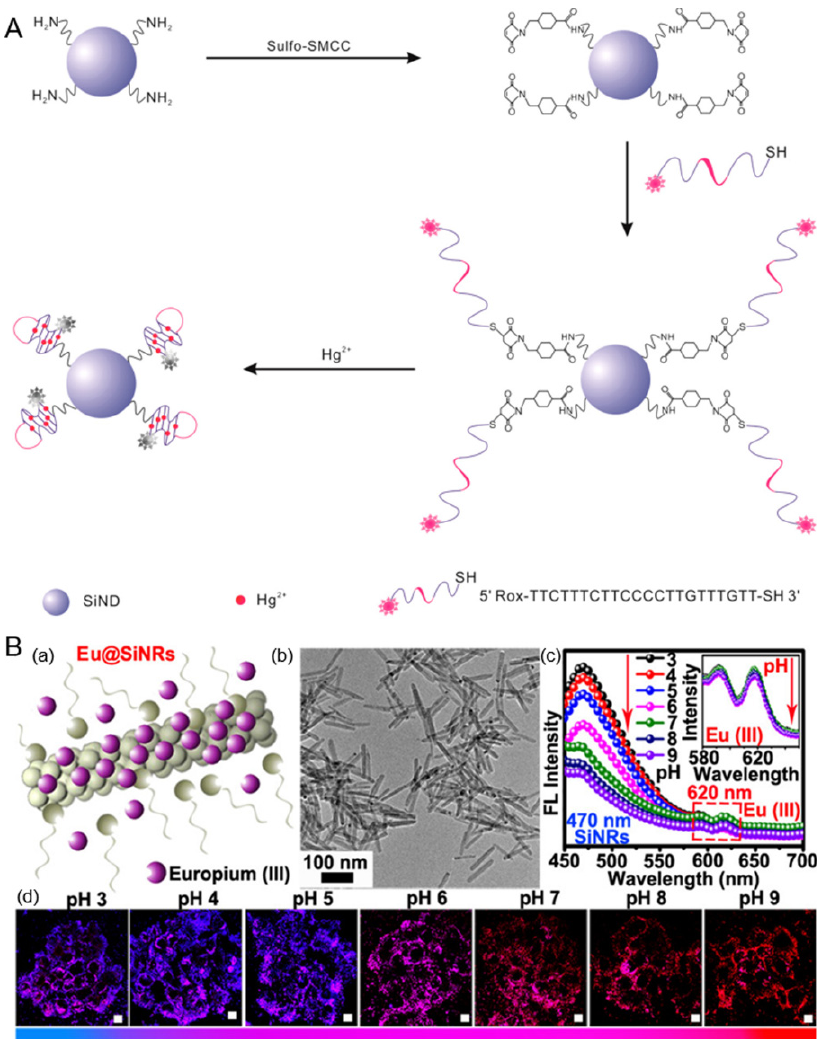
Figure 3. ( A ) Schematic presentation of the preparation of SiND-DNA-Rox and its application for ratiometric detection of Hg 2+ . Reproduced from [23], with permission from the American Chemical Society, 2018. ( B ) ( a ) Schematic of Eu@SiNRs sensor, ( b ) TEM image of Eu@SiNRs, ( c ) fluorescence spectra of Eu@SiNRs in PBS buffers with different pH values under 405 nm excitation, ( d ) a Eu@SiNRs-based pH sensor for ratiometric measurements of cytoplasmic pH in live cells. Reproduced from [56], with permission from the American Chemical Society, 2017.